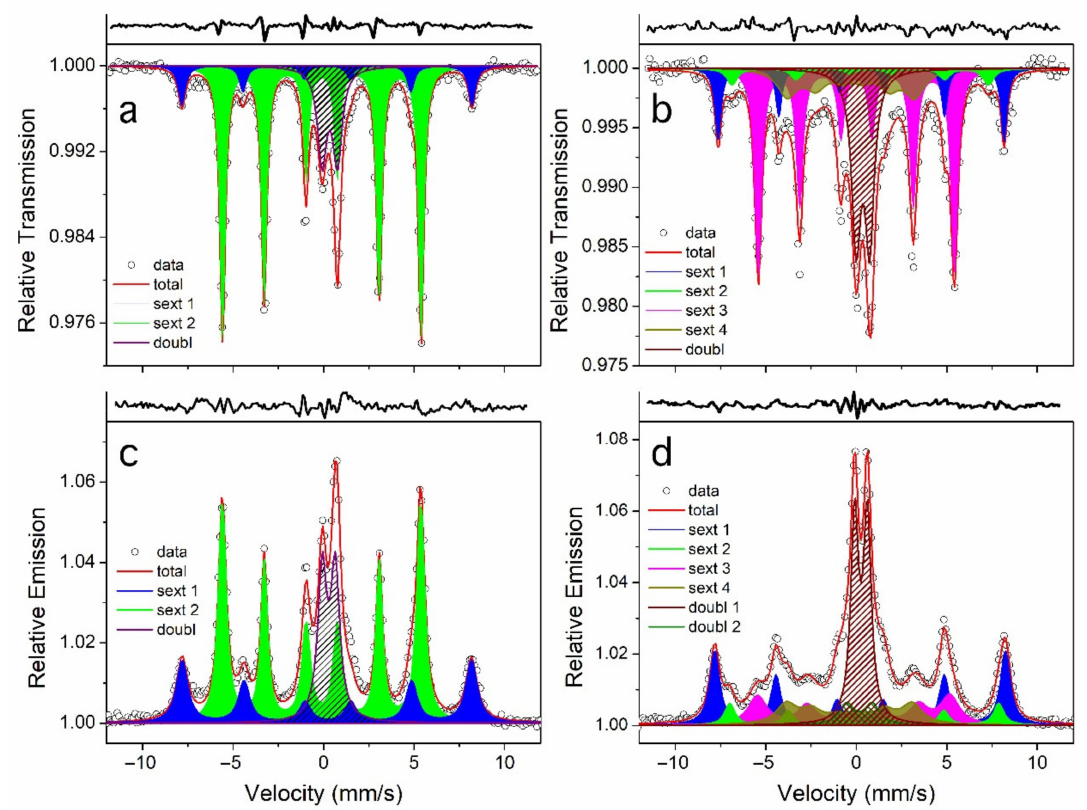
Figure 12. Mössbauer spectra of the exterior part of Find 1 iron meteorite ( a , c ) and Campo del Cielo meteorite ( b , d ) measured at RT in transmission ( a , b ) and backscattering ( c , d ) geometries. Table 3. Mössbauer parameters obtained from the fitting to the spectra shown in Figure 12 [31]. The errors in the last digit are given in